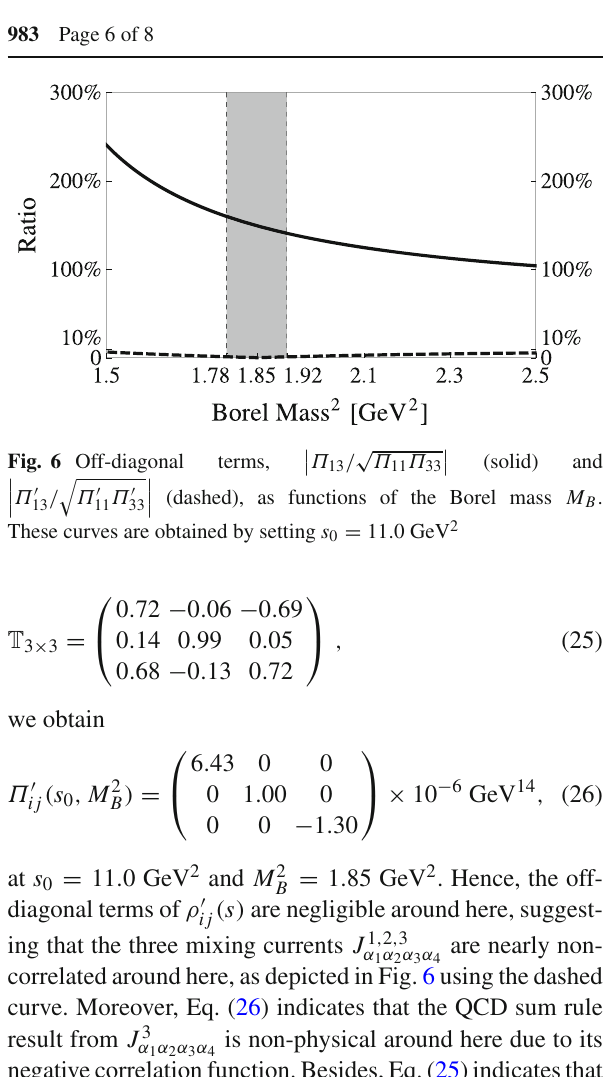
(cid:15) (cid:15) √ (cid:15) Π (cid:15) (solid) and / Π Π 13 11 33